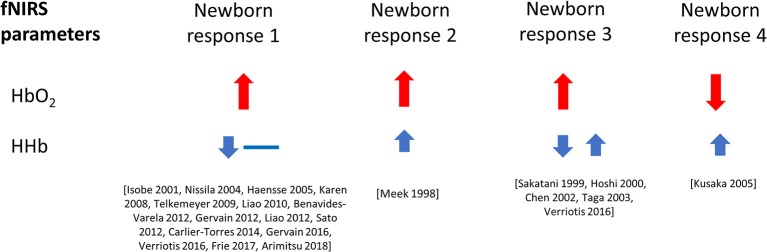
Haemodynamic responses to functional activation observed in newborns, with changes in Δ[HbO2] shown in red and Δ[HHb] shown in blue. Data is taken from literature identified in this review paper, and included above only when both variables, Δ[HbO2] and Δ[HHb], have been reported and discussed. The size of the arrows (small and large) relate to the magnitude of the response. Responses with a double arrow indicate a mixed response (both positive and negative changes observed).